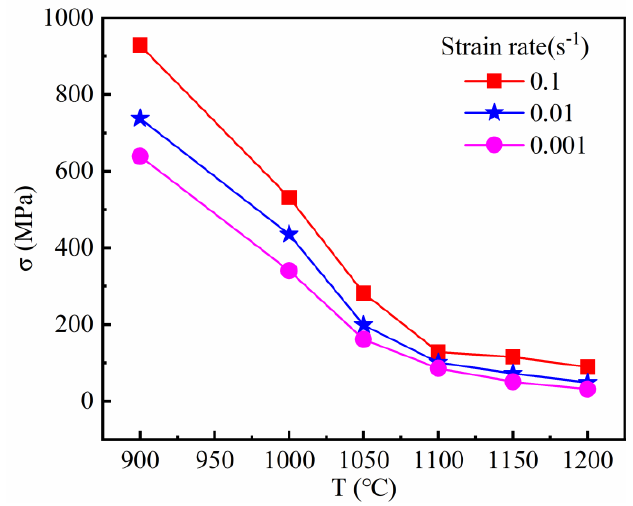
Figure 5. Relationship between peak stress and temperature and strain rate.